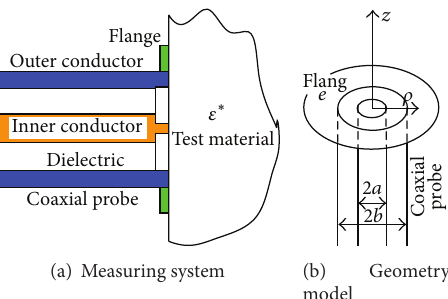
Figure 1: Measuring reflection coefficients with open ended coaxial probe.